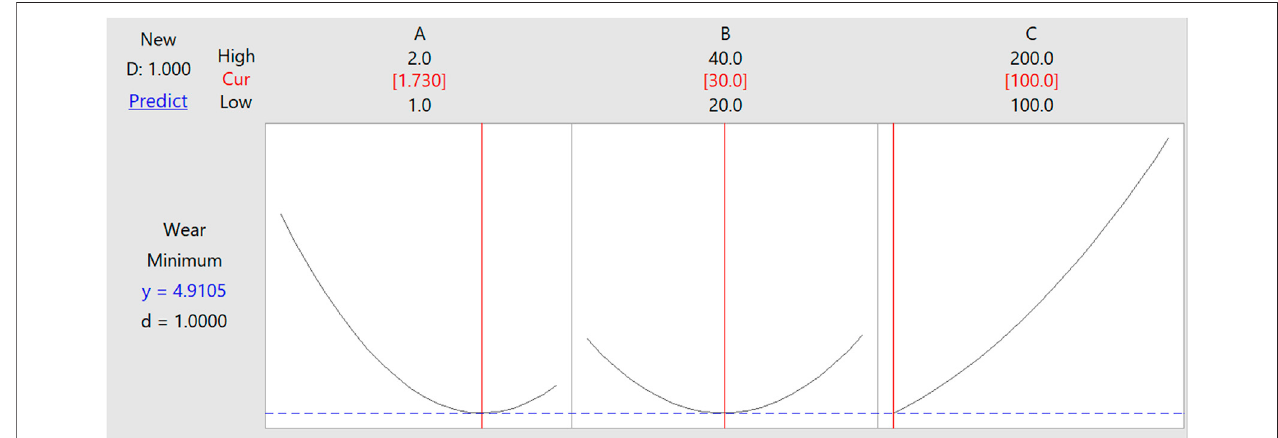
FIGURE 8 | Desirability plot for single-objective optimization of wear